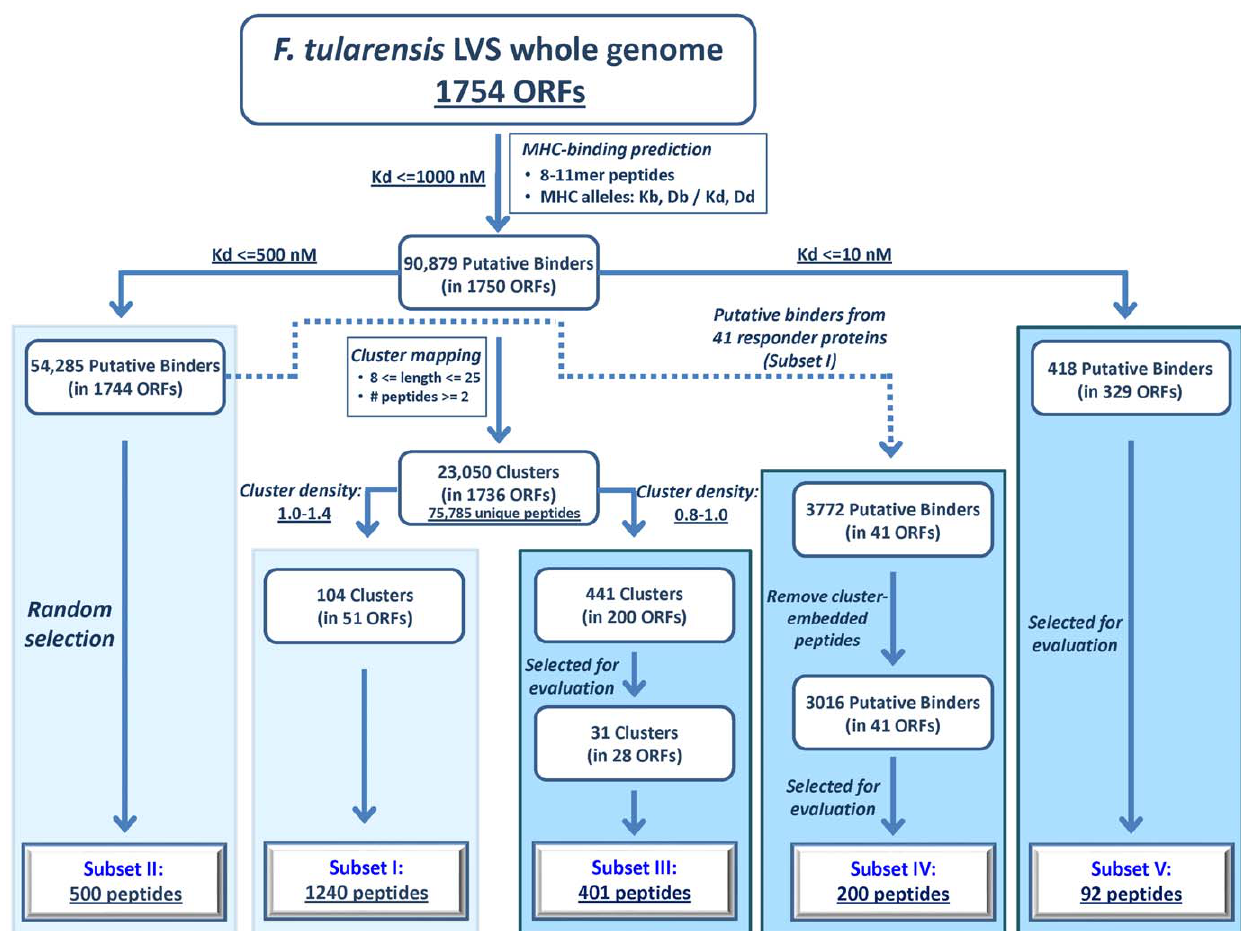
Figure 1. Flowchart of down-selection of putative MHC binders for experimental evaluation. The whole-genome immunoinformatic analysis conducted on the 1754 F. tularensis ORF products and the downstream selection of the various subsets of peptides is provided. Boxes shaded in light blue: Subsets I and II were described in a previous study [14] and are added for the sake of completeness. Boxes shaded in cyan: Subsets III–V of peptides selected and evaluated in this study. In all down selection steps referred to as : ‘‘Selected for evaluation’’ (in Subset III, IV and V), clusters or peptides are selected at random as an operational filter for reduction of number of peptides to be experimentally tested, unlike Subset II, were selection of peptides was at random with respect to clusters. Subset III contains 401 peptides selected from clusters having density of 0.8 up to 1.0 (1.0 not included); Subset IV is composed of 200 peptides selected from the overall 3016 predicted MHC binders (IC 50 , =500 nM) located outside the high-density cluster regions in the 41 source proteins of Subset I (Figure 2); Subset V includes 92 predicted epitopes having an IC 50 of 10 nM and lower, representing putative high-affinity MHC binders.